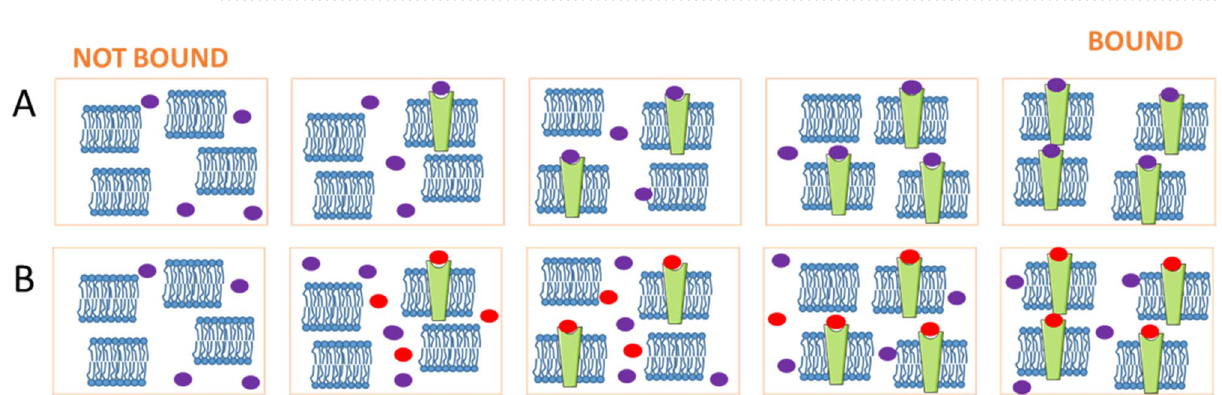
Figure 2. Binding check before saturation curve. The binding check allows the comparison of MST signal for 0.125 nM spiperone—Cy5 in presence of induced HekD2, buffer or HekWT ( A ). A one-way ANOVA analysis of variance has been used to compare the conditions. A significant difference is observed between HekWT and HekD2, and HekWT and buffer with P-value < 0.0001 (***). No significant difference is observed between HekD2 and Buffer conditions (ns). The total protein concentration was set similar in HekD2 and HekWT. Saturation curve obtained when HekD2 membrane fragments were diluted in buffer with 0.125 nM spiperone— Cy5 ( B ).